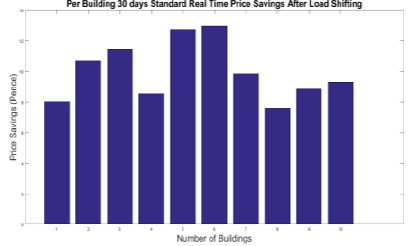
Figure 10. Users’ monthly price reduction